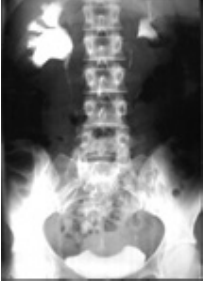
FIGURE 2 . Excretory phase of intravenous pyelography demonstrating obstruction at the ureteropelvic junction. This patient is the identical twin of the patient shown in Figure 1.